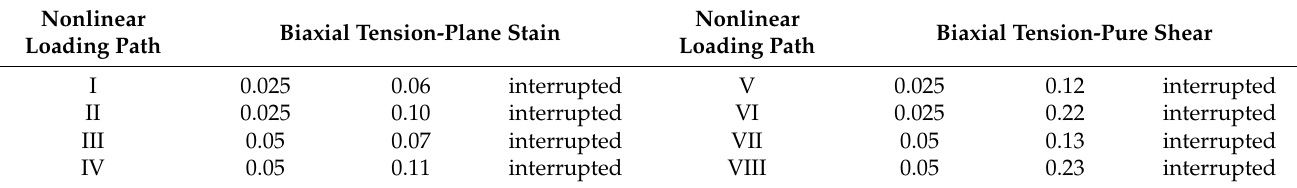
Table 9. Experimental procedure for Biaxial-plane stain/shear